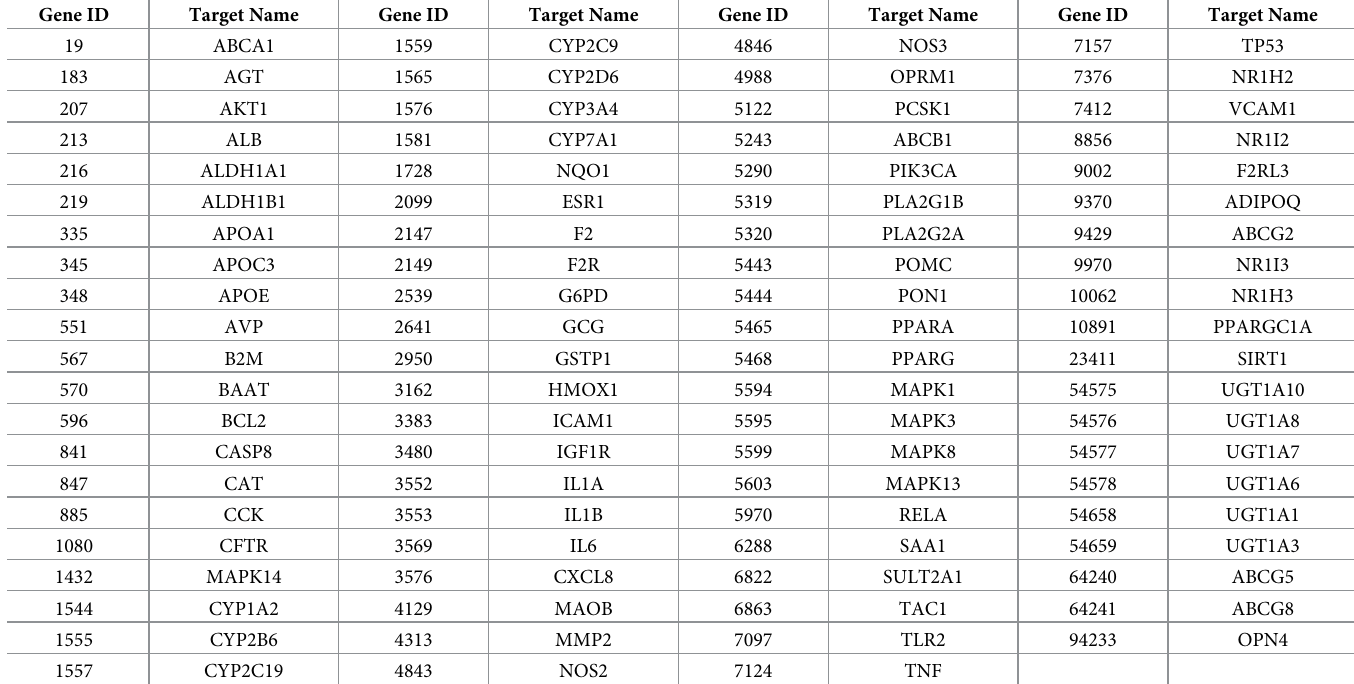
Table 2. 83 potential targets of SHCZF against